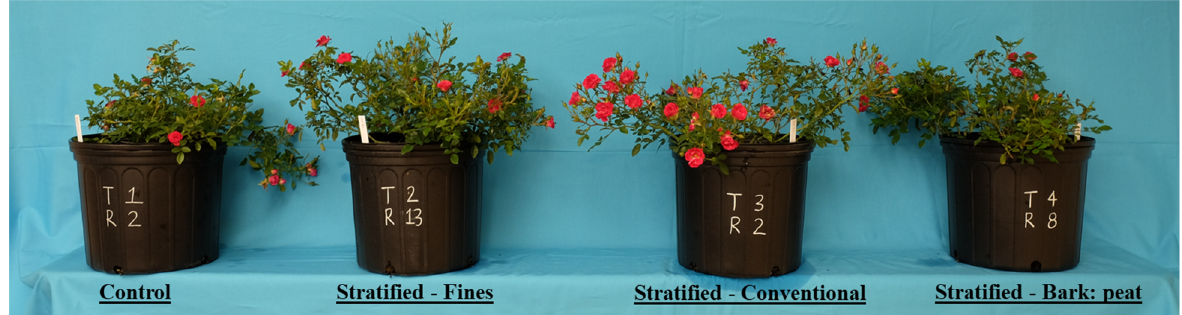
Figure 4. Side view of Drift roses 125 days after initiation. Roses were grown by utilizing either a conventional pine bark substrate (control) or stratified substrates, in which either conventional pine bark substrate amended with 35% peat (by vol.; bark–peat), conventional pine bark (conventional), or fine pine bark (fines) was layered on top of a coarse screened pine bark. Plants were irrigated with 16 mm daily.